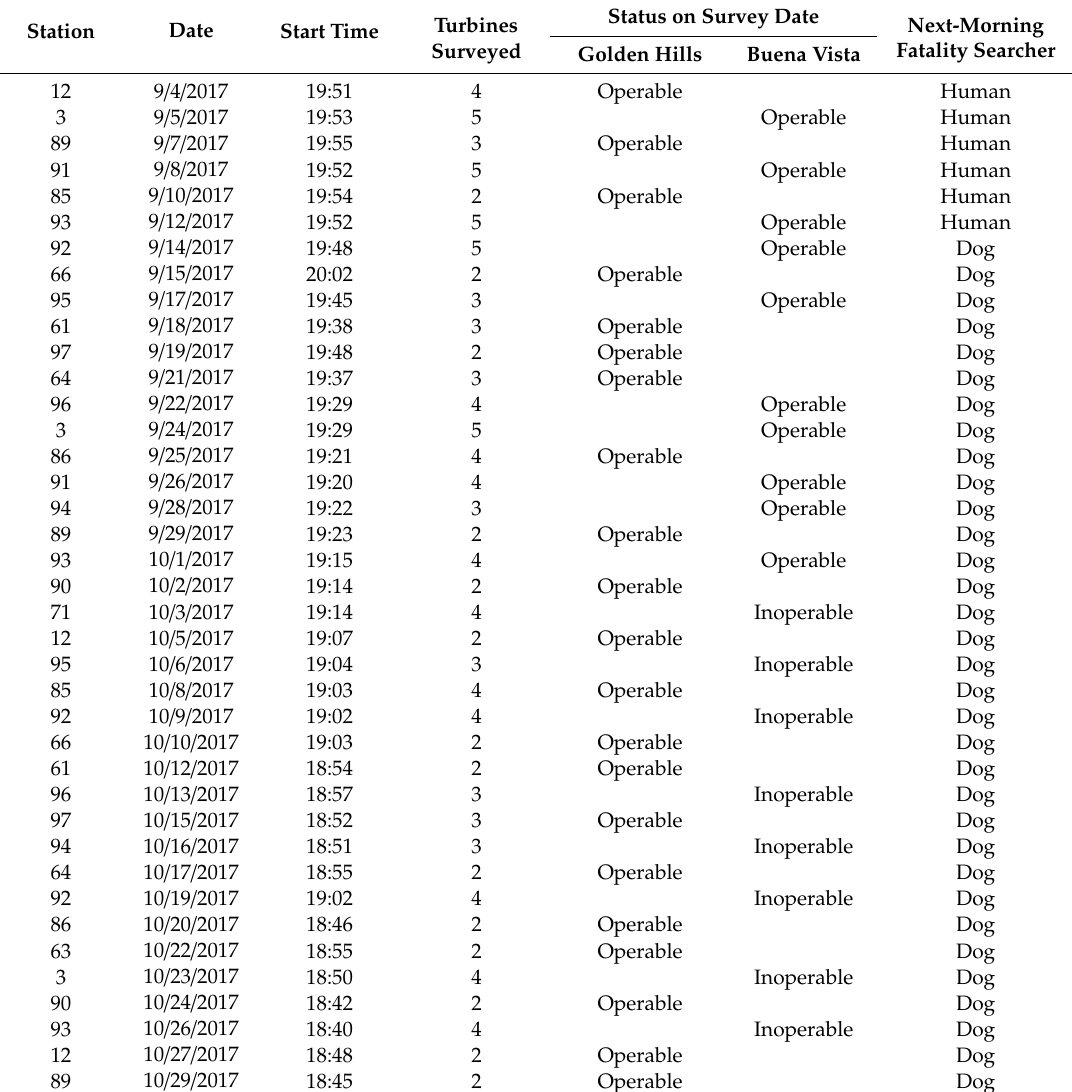
Table 1. Nocturnal survey dates and start times (Pacific Standard Time) and the number and operational status of wind turbines